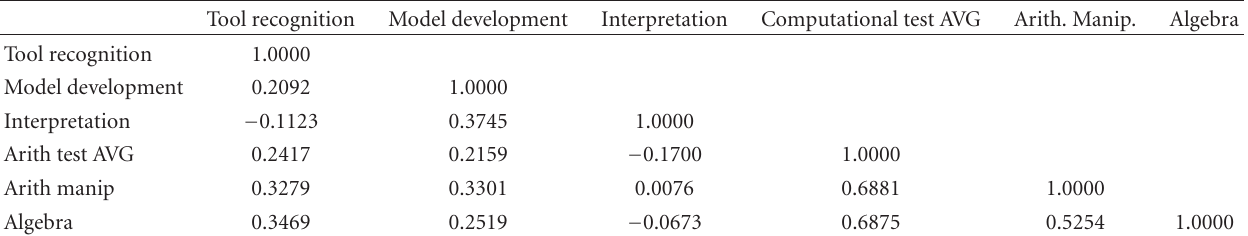
Table 1: Correlation